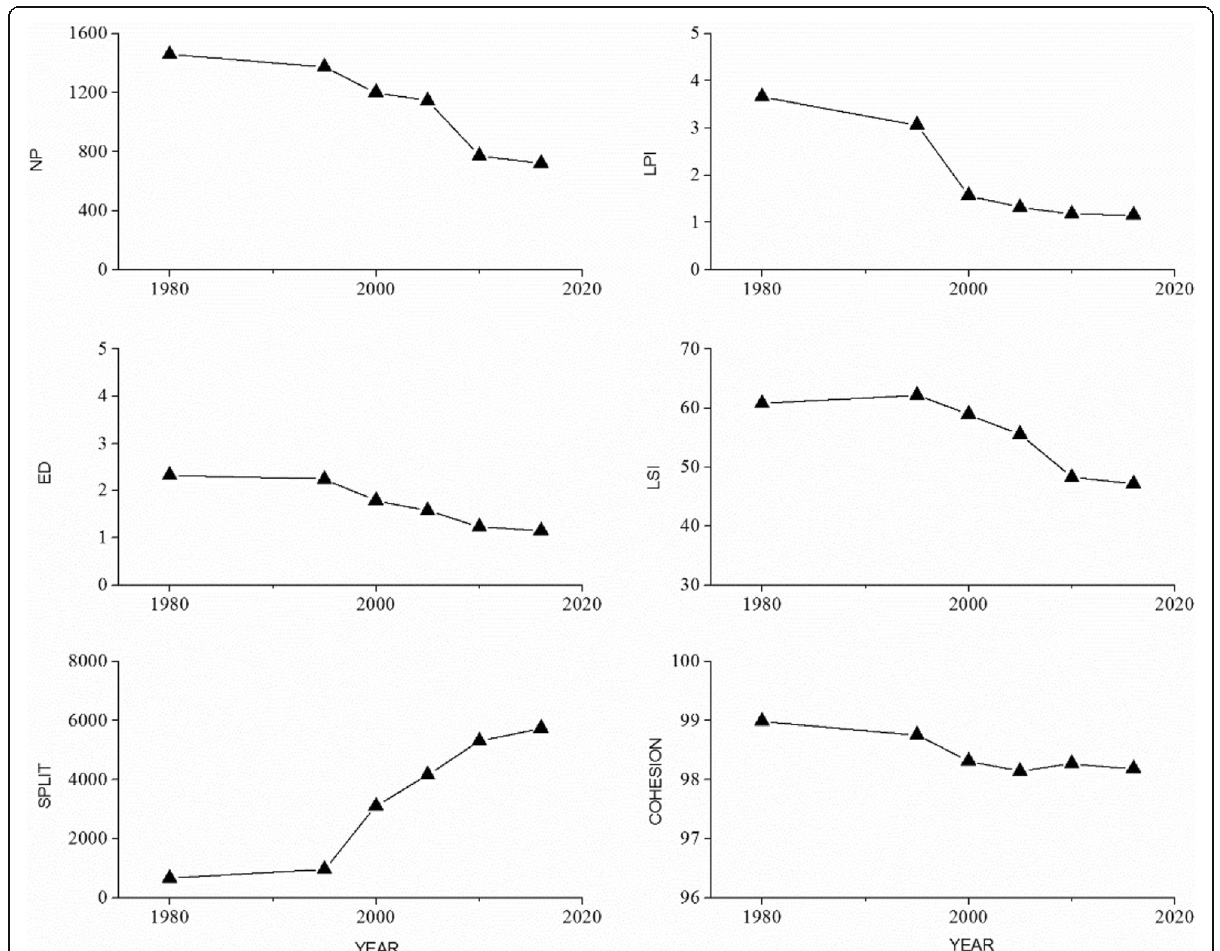
Fig. 6 Landscape pattern changes in marshlands at category level during 1980 –